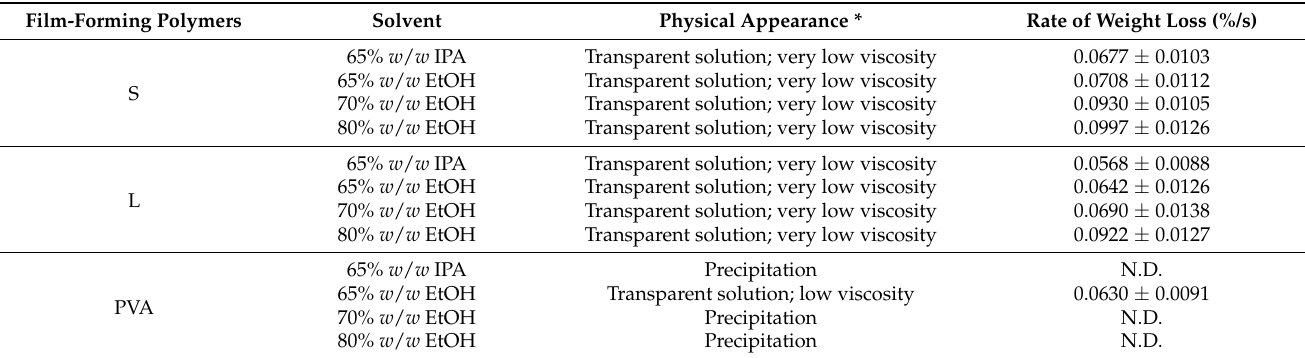
Table 2. Physical appearance and rate of the weight loss of the FFS prepared from the various types and concentrations of the solvent systems.